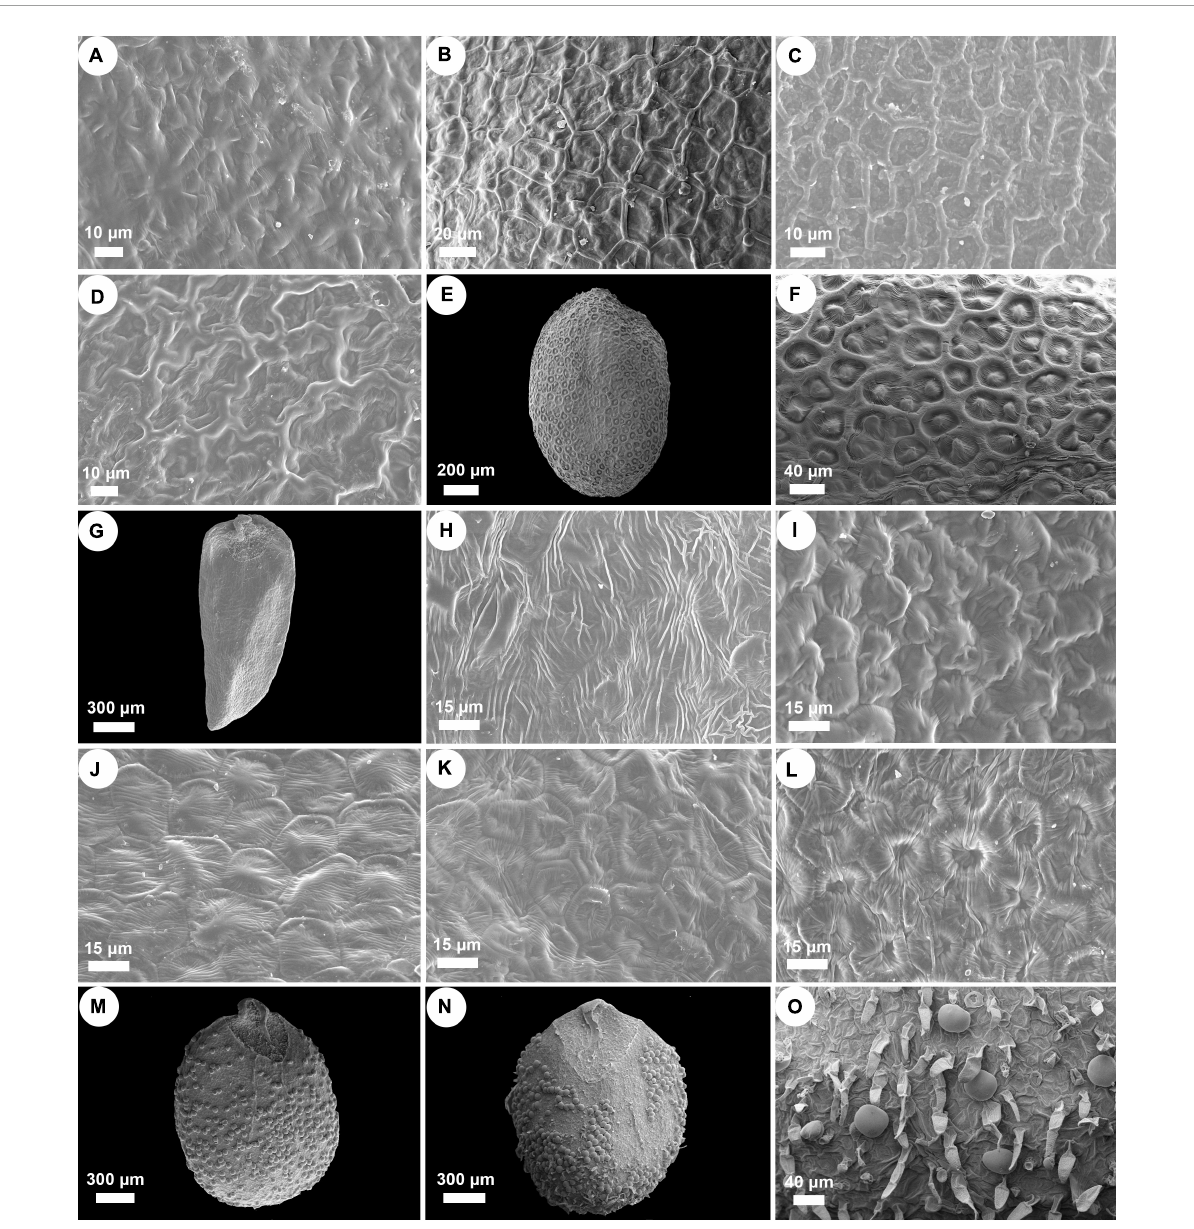
FIGURE4 SEM micrographs of nutlet surface pattern in Isodon . (A) Psilate surface. I. lophanthoides . (B–D) Reticulate surface. (B) I. oreophilus ; (C) I. phyllopodus ; (D) I. scrophularioides . (E,F) Reticulate-papillate surface. I. schimperi . (G,H) Striate surface. I. ternifolius . (I–L) Cellular